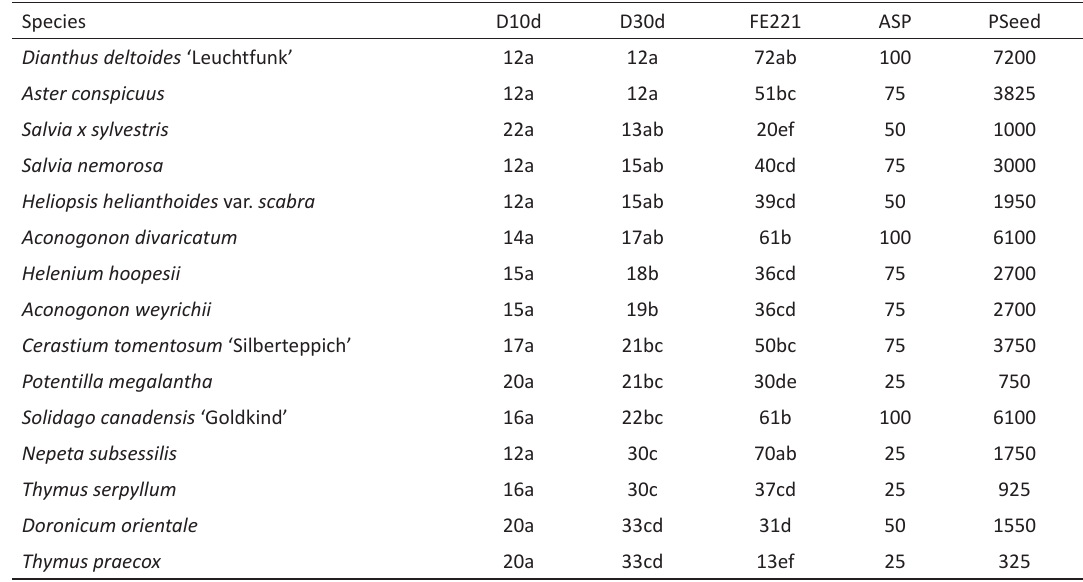
Table 6. Germination of the seeds in the germination experiment. Duration in days from sowing to 10% emergence (D10d) and to 30% emergence (D30d), final emergence 221 days after sowing (FE221), seed production abundance (ASP) and potential for spread by seed (PSeed (PSeed = FE221 × S)) in 2013. Species with the same superscripted letter in columns D10d, D30d and FE221 do not differ statistically in post-hoc pair-wise comparison. Fifteen species which had at least 30% emergence rate in 35 d.a.s. are shown and are ranked by D30d.